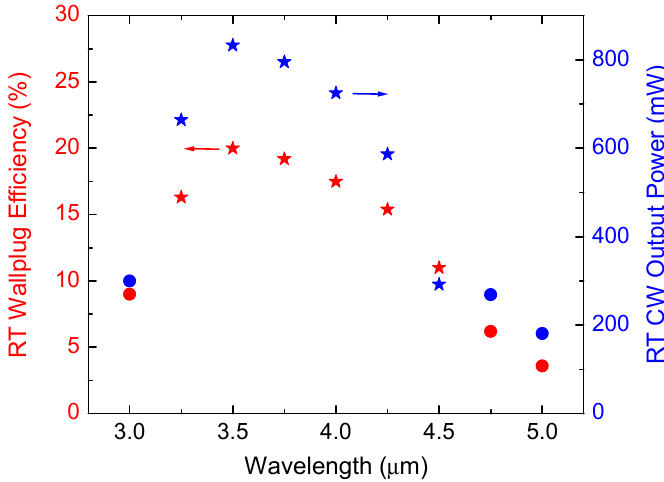
Figure 28. Projected maximum room-temperature continuous-wave output powers (blue) and wall-plug efficiencies (red) for 7-stage ICLs with the best state-of-the-art characteristics measured for broad-area pulsed devices. For wavelengths between 3.25 and 4.5 μ m (stars), the maximum output power is presented for WPE > 10%, while the maximum WPE is shown for an output power exceeding 200 mW. Outside this wavelength range (circles), the absolute maximum values are displayed. The ridge width and cavity length were varied to obtain these results, with the maximum cavity length fixed at 4 mm. An HR coating was assumed for the back facet, and a 3% AR coating for the front